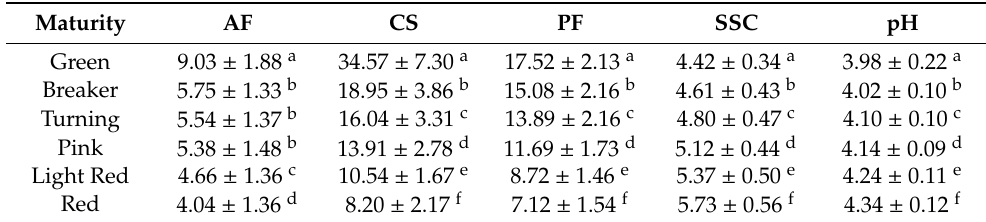
Table 1. Means and standard deviations of the quality parameters for tomatoes with different maturities